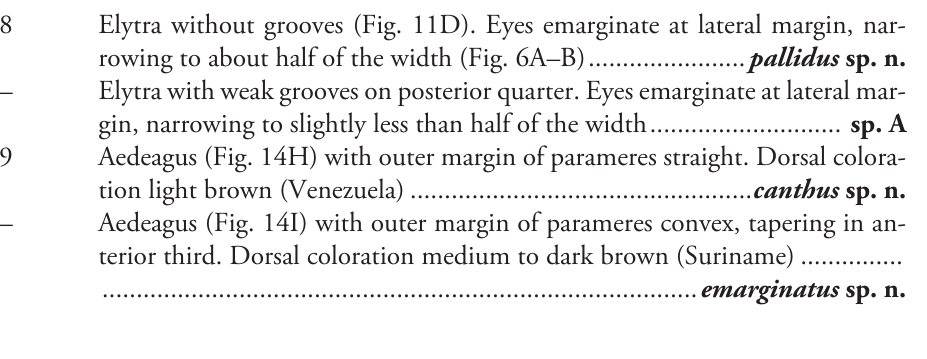
Elytra without grooves (Fig. 11D). Eyes emarginate at lateral margin, nar- rowing to about half of the width (Fig. 6A–B) ....................... pallidus sp. n. Elytra with weak grooves on posterior quarter. Eyes emarginate at lateral mar- gin, narrowing to slightly less than half of the width ............................ sp. A Aedeagus (Fig. 14H) with outer margin of parameres straight. Dorsal colora- – Aedeagus (Fig. 14I) with outer margin of parameres convex, tapering in